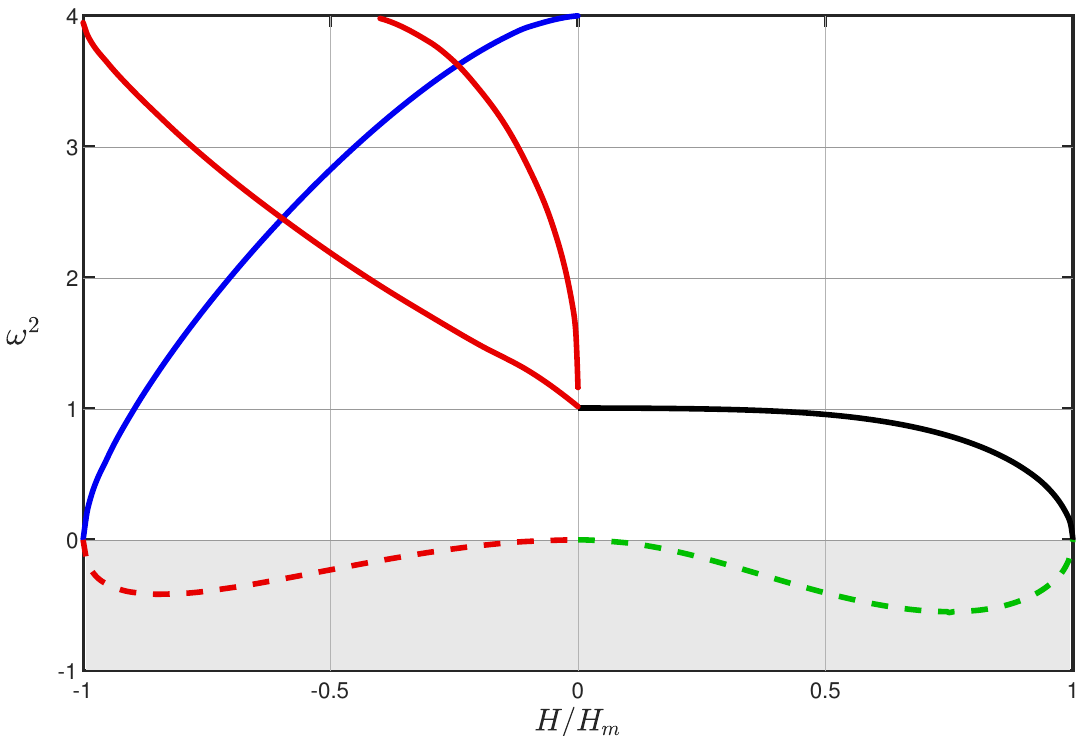
Figure 7 . The squared frequencies ω 2 of localized boundary modes as a function of H. The curves are for solutions φ 1 ( x ) (black solid line) and φ 2 ( x ) (green dashed line), ˜ φ 1 ( x ) (blue solid line) and ˜ φ 2 ( x ) (red dashed and solid